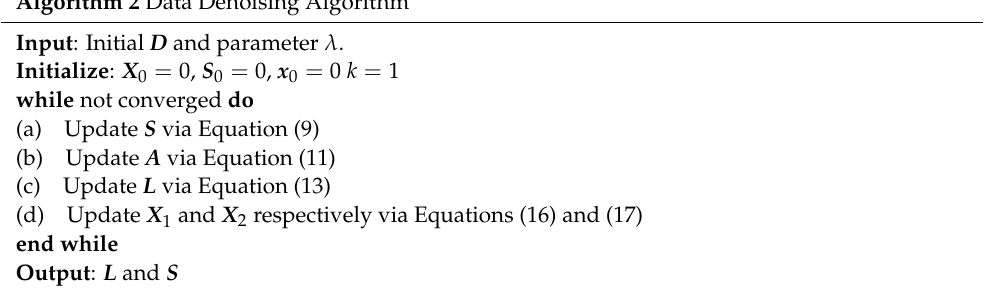
Algorithm 2 Data Denoising Algorithm